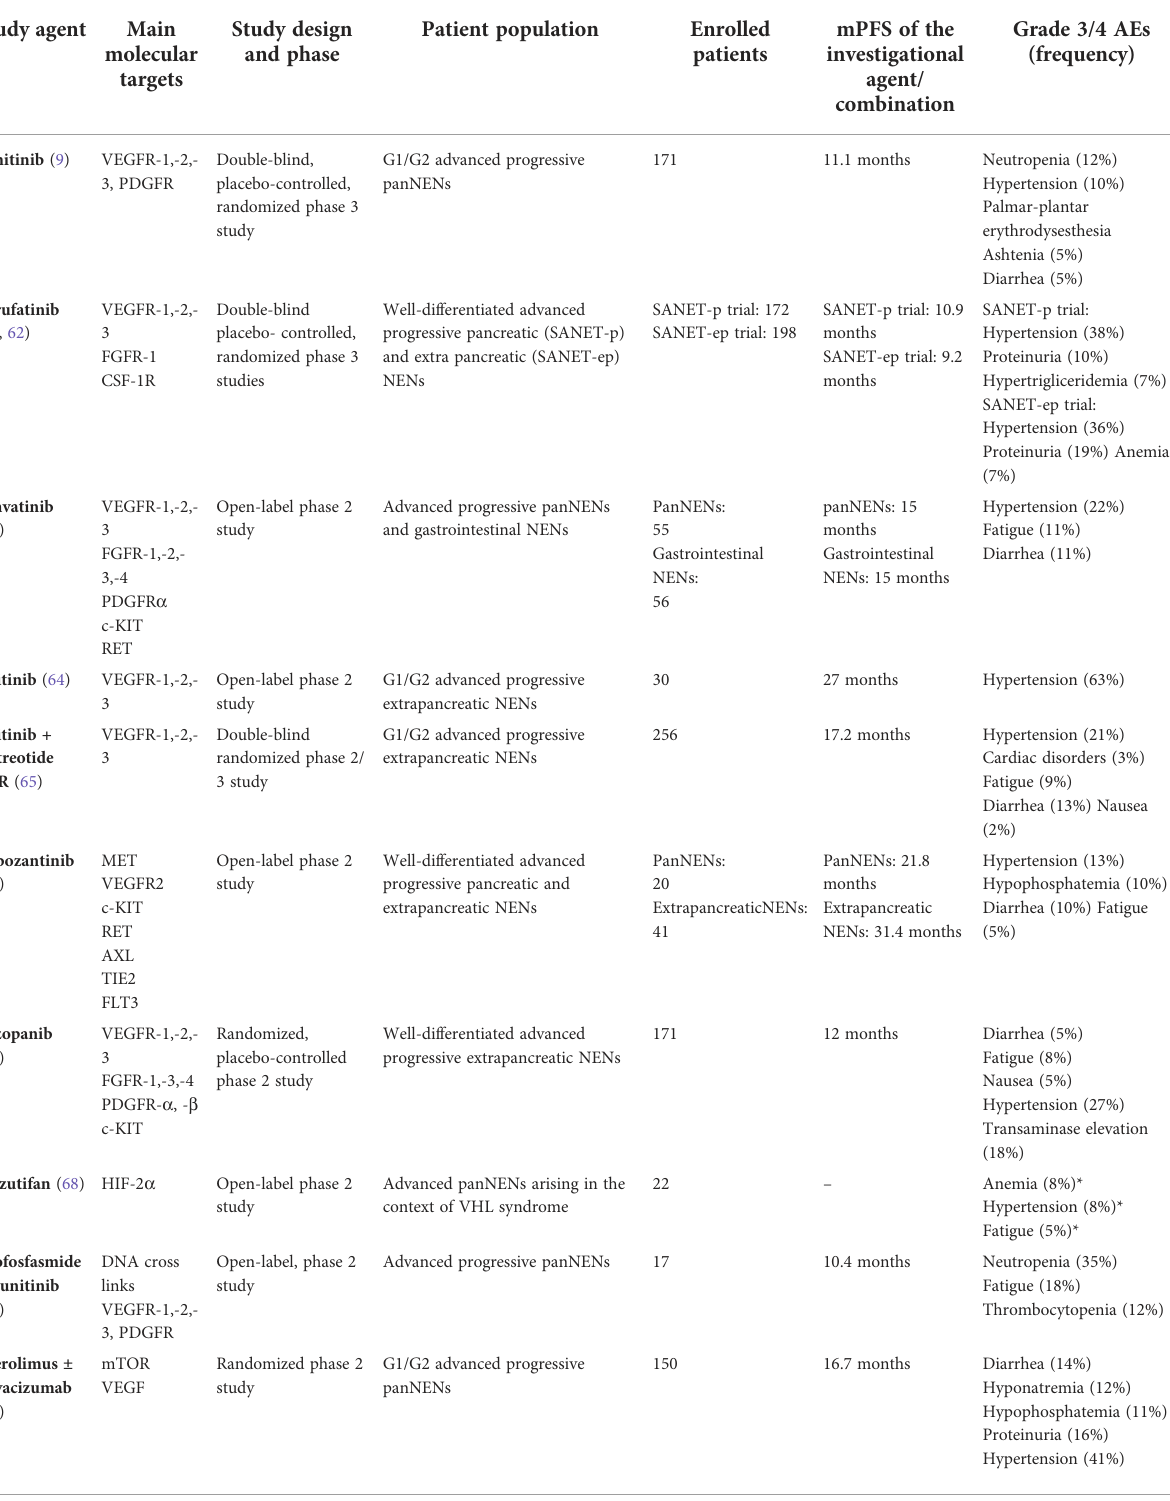
TABLE 1 An overview of completed studies with antiangiogenic agents in patients with